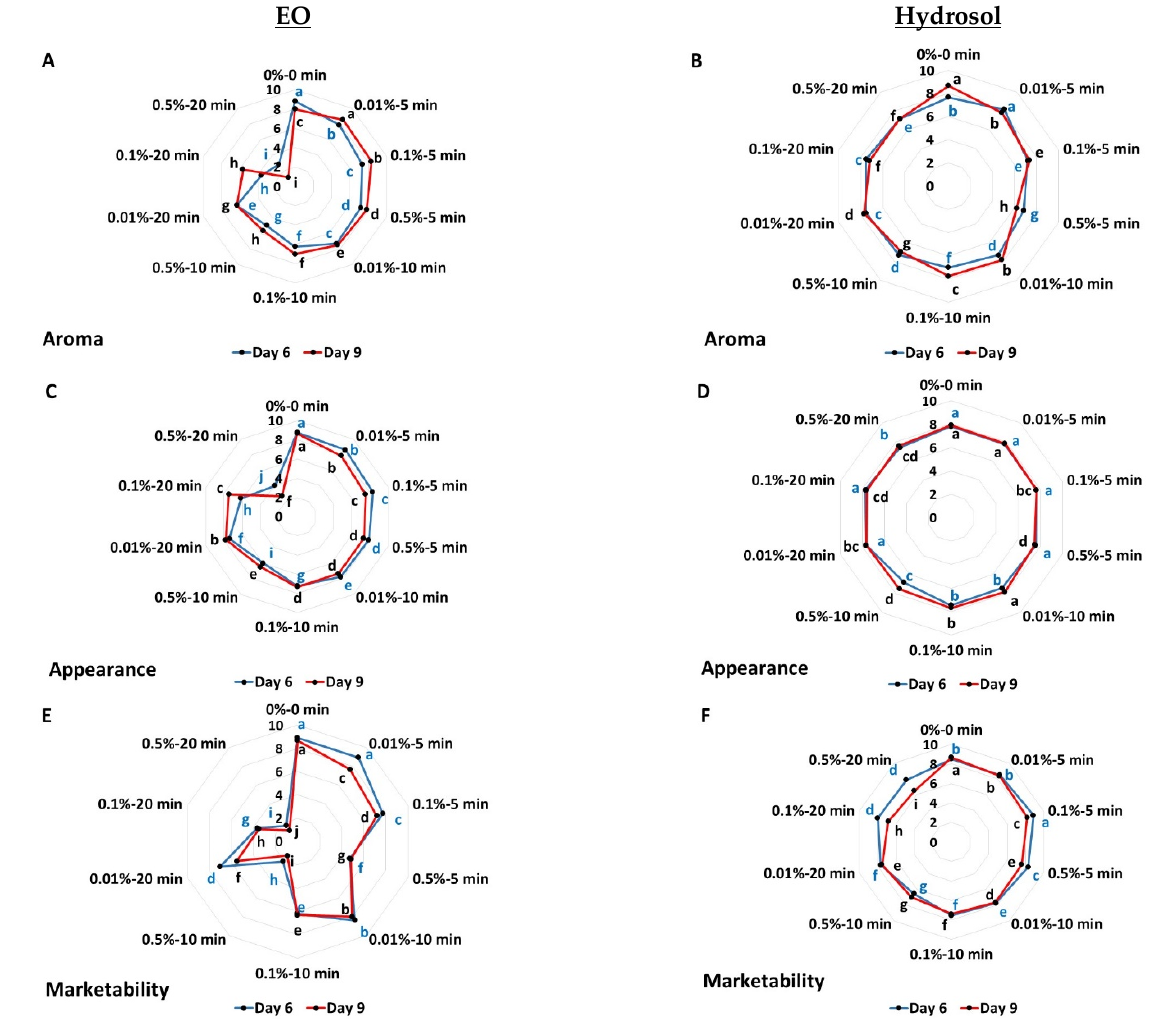
Figure 4. Screening of O. dubium EO ( A , C , E ) and hydrosol ( B , D , F ) application effects on sensory attributes: aroma (aroma, appearance and marketability) of cucumber fruit stored at 11 °C for 9 days. Different Latin letters indicate significant differences at p < 0.05.